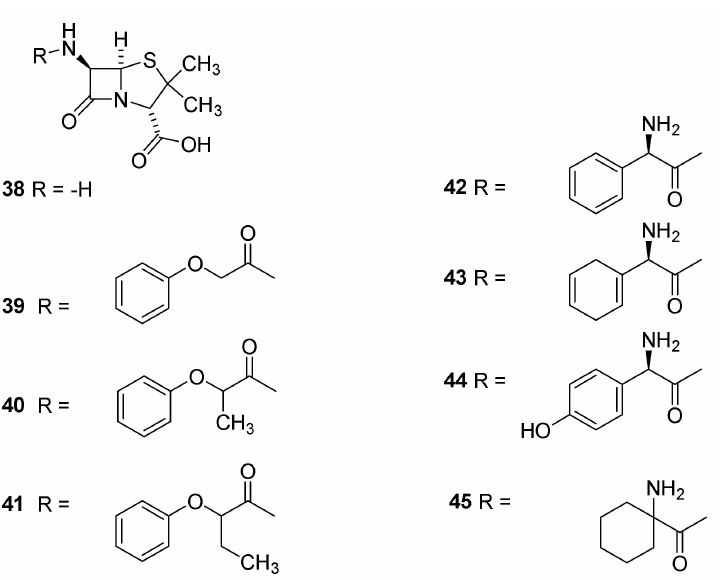
Figure 9. Semisynthetic penicillins. Phenoxyacyl penicillins: phenoxymethyl penicillin/penicillin V (Vepicombin, 39 ), phenoxyethyl penicillin (phenithicillin, 40 ), Phenoxypropylpenicillin ( 41 ) [63,64]. Aminoacylpenicillins ampicillin ( 42 ), epicillin ( 43 ), amoxicillin ( 44 ) and cyclacillin ( 45